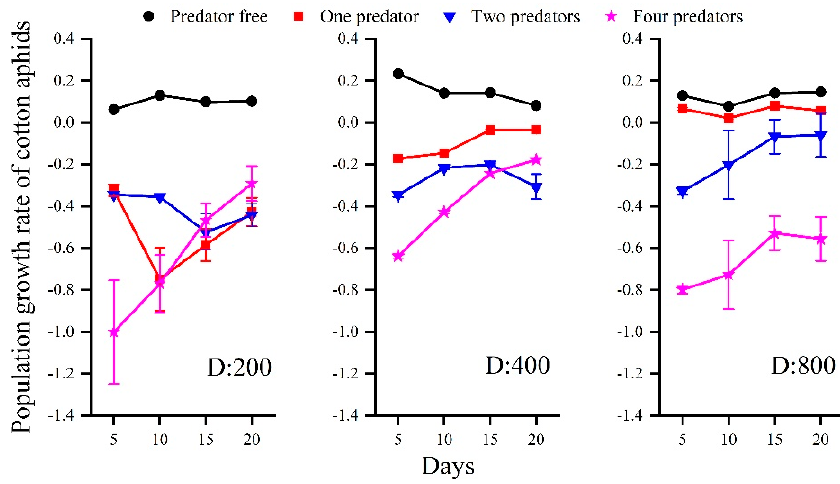
Figure 2. Population growth rate of cotton aphids in using three initial numbers of aphids (200, 400, and 800), and four numbers of predator beetles (0, 1, 2, and 4).